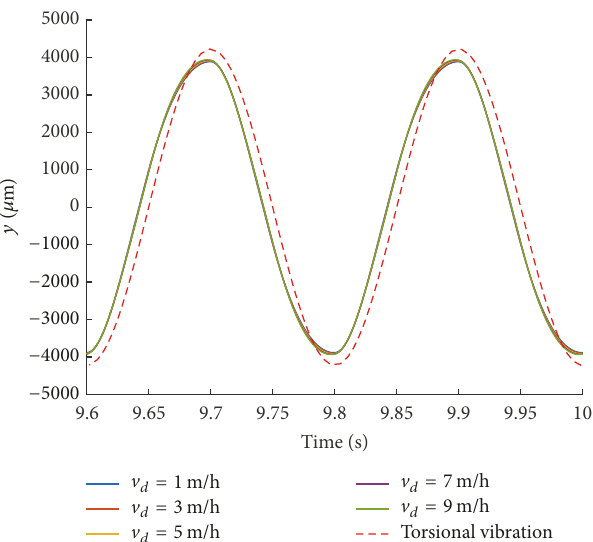
Figure 19: Friction force of bristle deformation and viscous fluid in time domain.